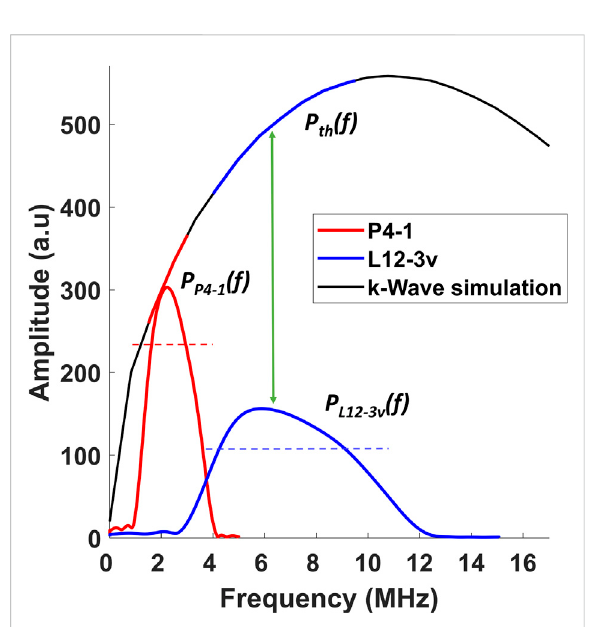
FIGURE 2 Visual description of the methodology used for calculating the sensitivity compensation ratio mathematically represented in Eq. 10. The dotted blue and red lines represent the range of the frequencies within the − 3 dB level. The solid blue and red lines represent the range of frequencies on P th (f). The green arrow visualizes the effect of the sensitivity compensation